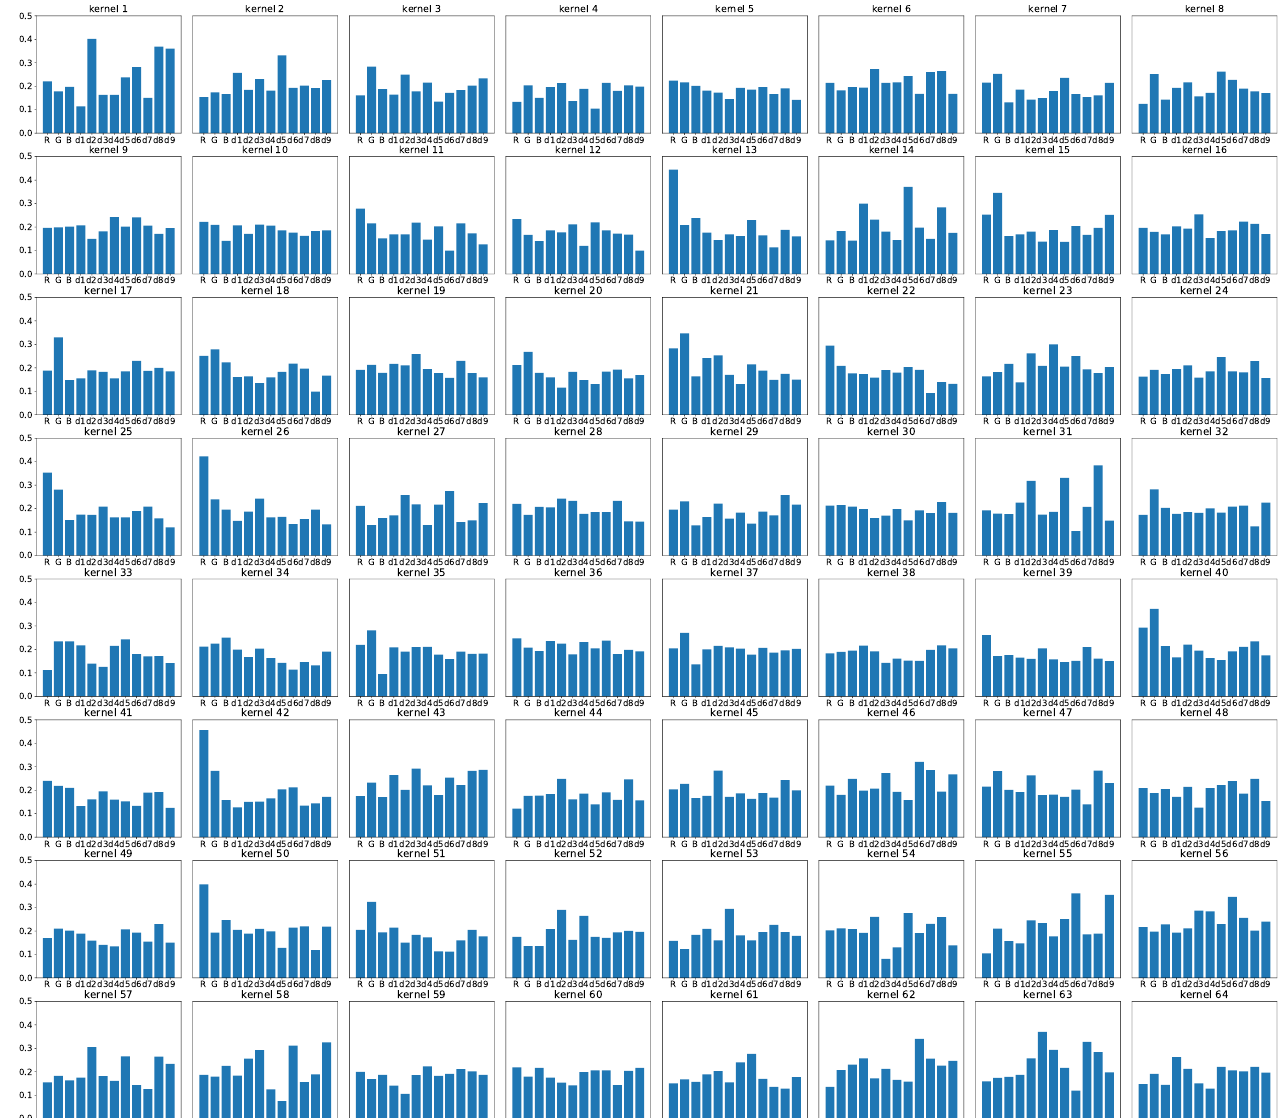
Figure 7. The sum of the absolute values of each input channel for each kernel. The horizontal axis represents the different input features of the segmentation module, R, G, B, d 1, d 2, d 3, d 4, d 5, d 6, d 7, d 8, and d 9 from left to right. The vertical axis of all subfigures are shown in the same range [0, 0.5]. The graph above shows that the color-ratio maps play an essential role, with some kernels showing larger in the color-ratio maps than in the RGB feature